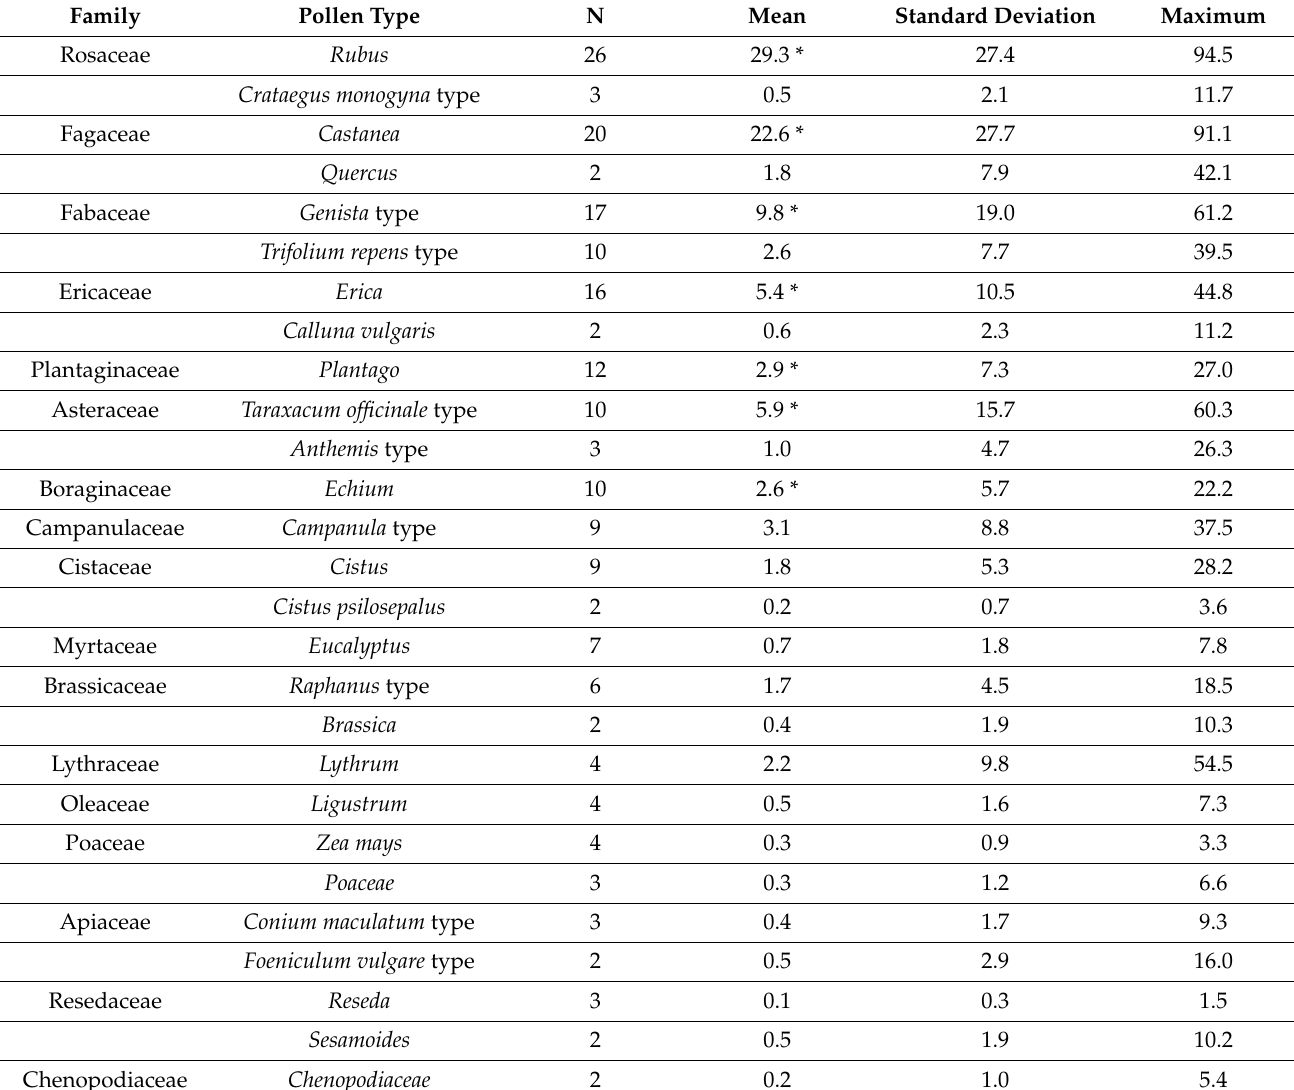
Table 1. Most-representative families and pollen types in the bee pollen samples produced in Galicia.